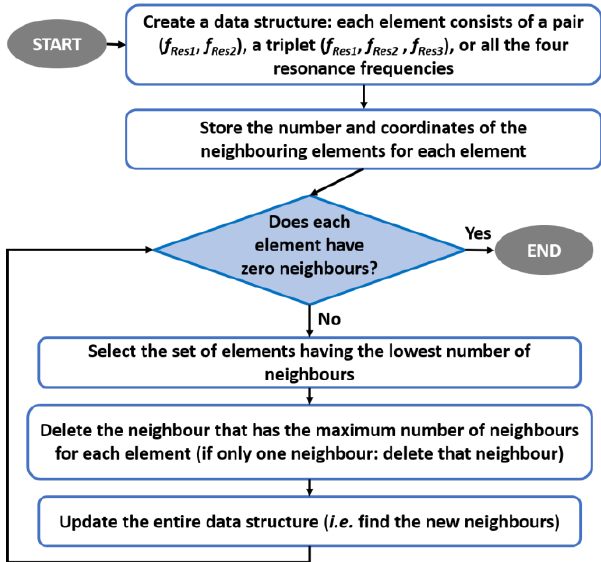
Figure 12. Flow chart of the algorithm to select the maximum number of unambiguous identification states.